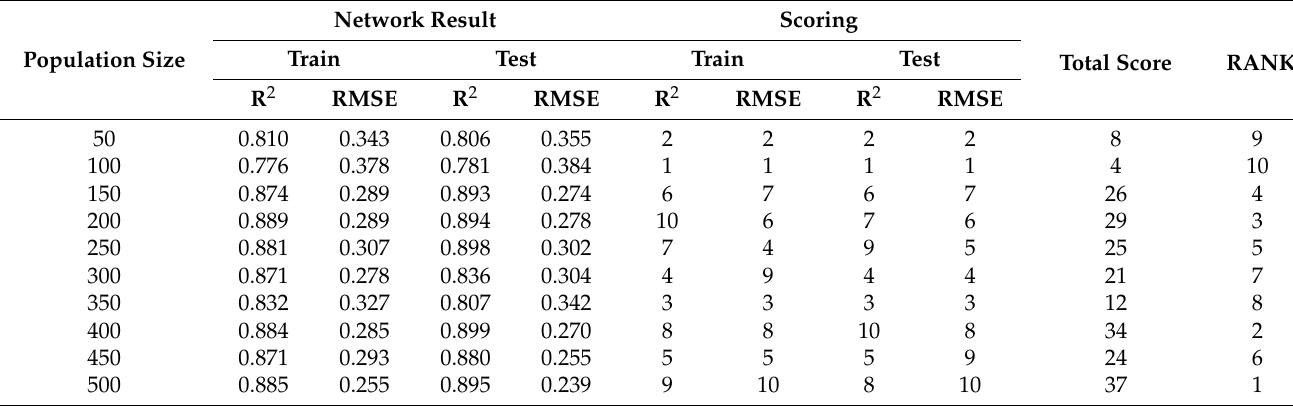
Table 2. The network results for the SOSA-MLP.